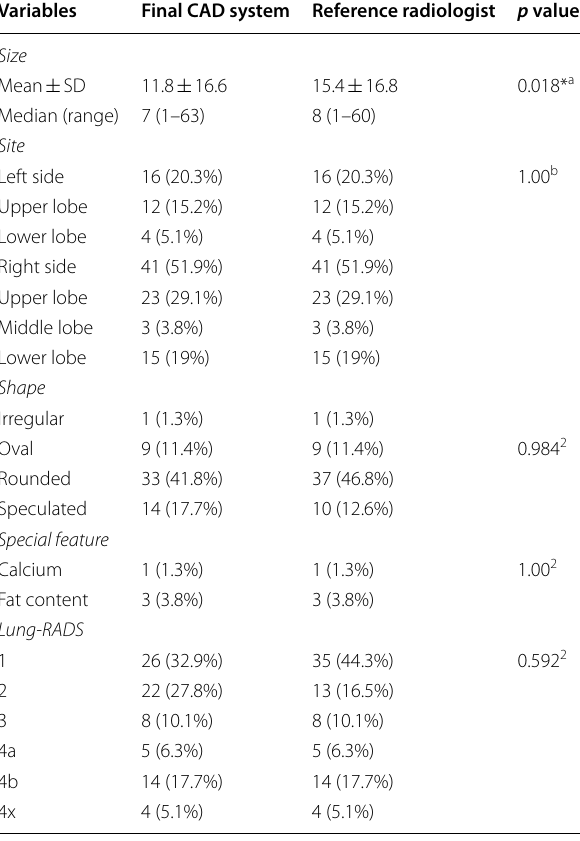
*Statistically significant as p < 0.05